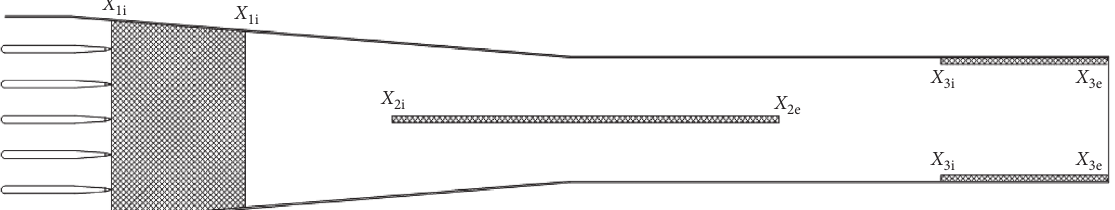
Figure 14: Location of the triple wave